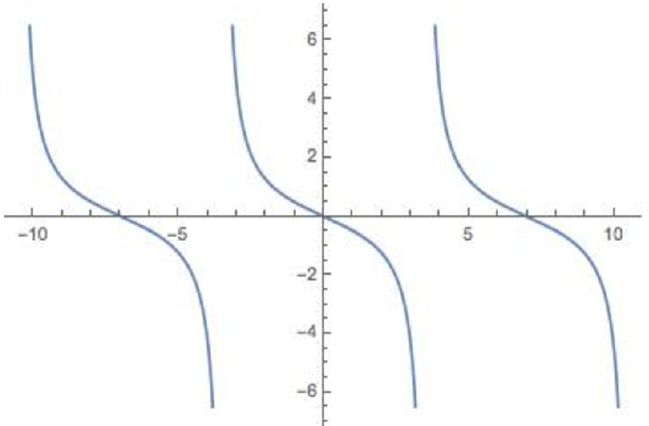
Figure 2 . Plot of the RG (cid:13)ow of ^ (cid:21)=(cid:24) s vs ln (cid:15)=(cid:15) ? where ^ (cid:21) = ( (cid:21)= 2 (cid:25)(cid:15) ) + 1 and ( d (cid:0) 2) 2 = 4 < (cid:11) < d ( d (cid:0) 4) = 4 + $ 1 is chosen so that (cid:16) s = i(cid:24) s is imaginary. ^ (cid:21) strictly decreases as (cid:15) grows, and the parameter (cid:15) ? is chosen such that ^ (cid:21) ( (cid:15) ? ) = 0. where n = 0 ; (cid:6) 1 ; (cid:6) 2 ; (cid:1) (cid:1) (cid:1) up until n is so large that j E